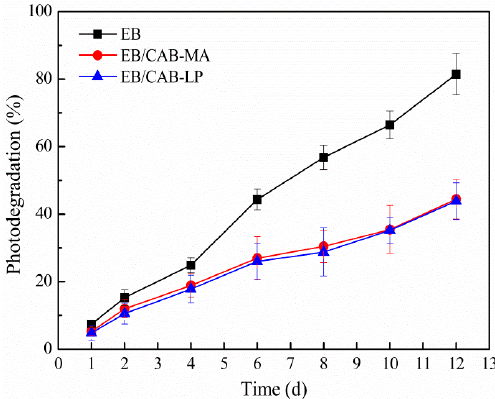
Figure 10. The photodegradation of EB in the control and entrapped in the microspheres ( n = 3).